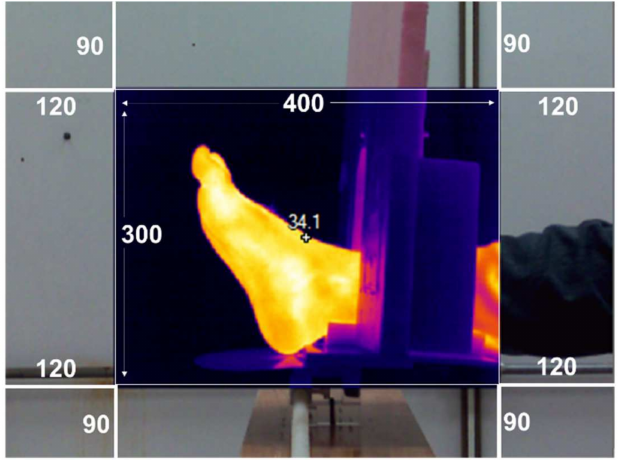
Figure 8. Multimodal superimposed images without RoI